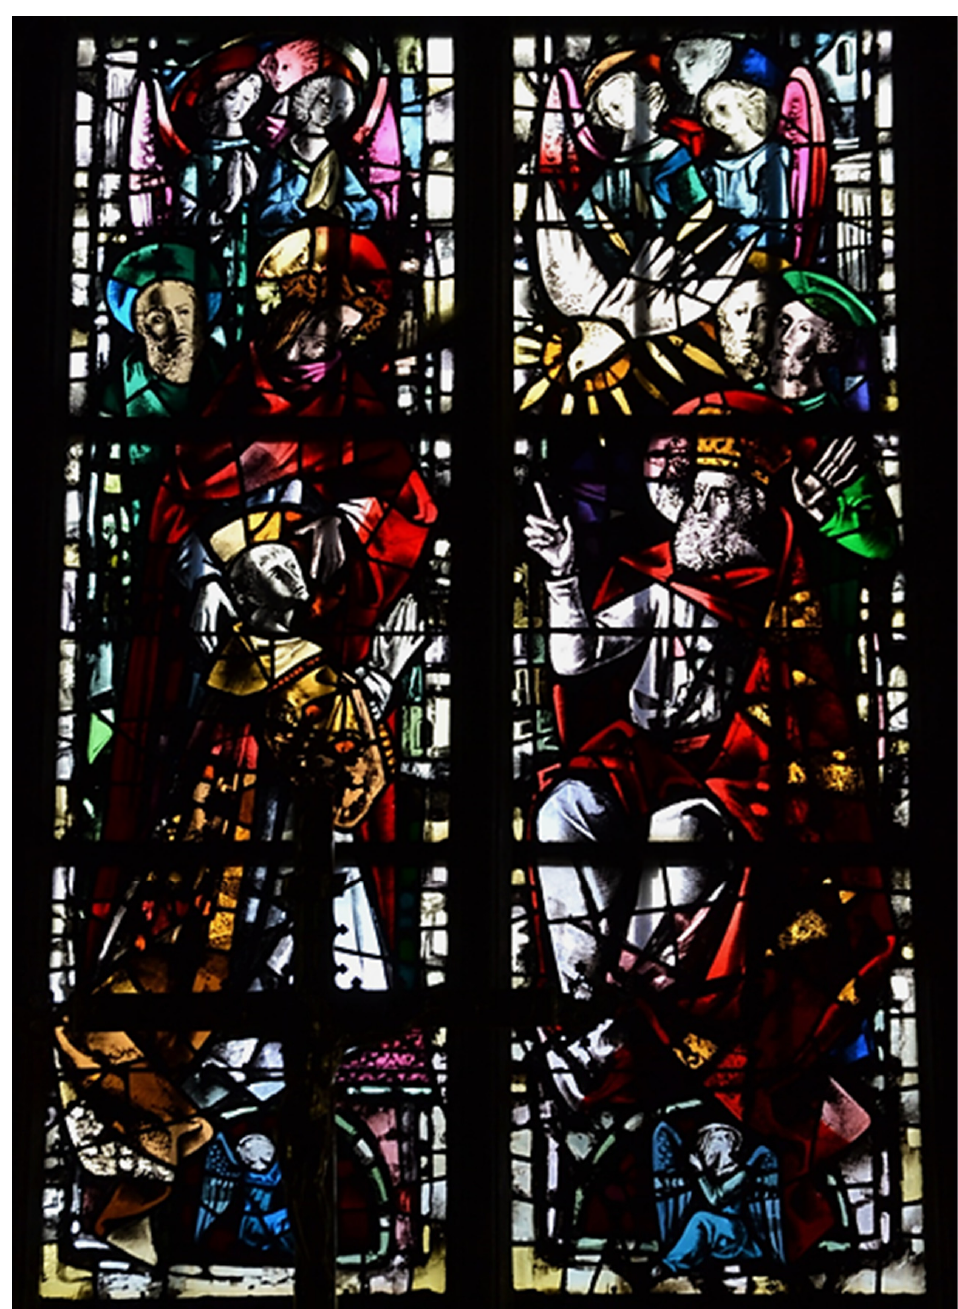
Figure 16. Saint-Lô, Church of Notre-Dame, Saint-Thomas chapel, Life of Saint Thomas window, Figure 16. Saint-L ô , Church of Notre-Dame, Saint-Thomas chapel, Life of Saint Thomas window, 1968, detail, Christ presents Saint Thomas to God the Father. © author. 1968, detail, Christ presents Saint Thomas to God the Father. ©